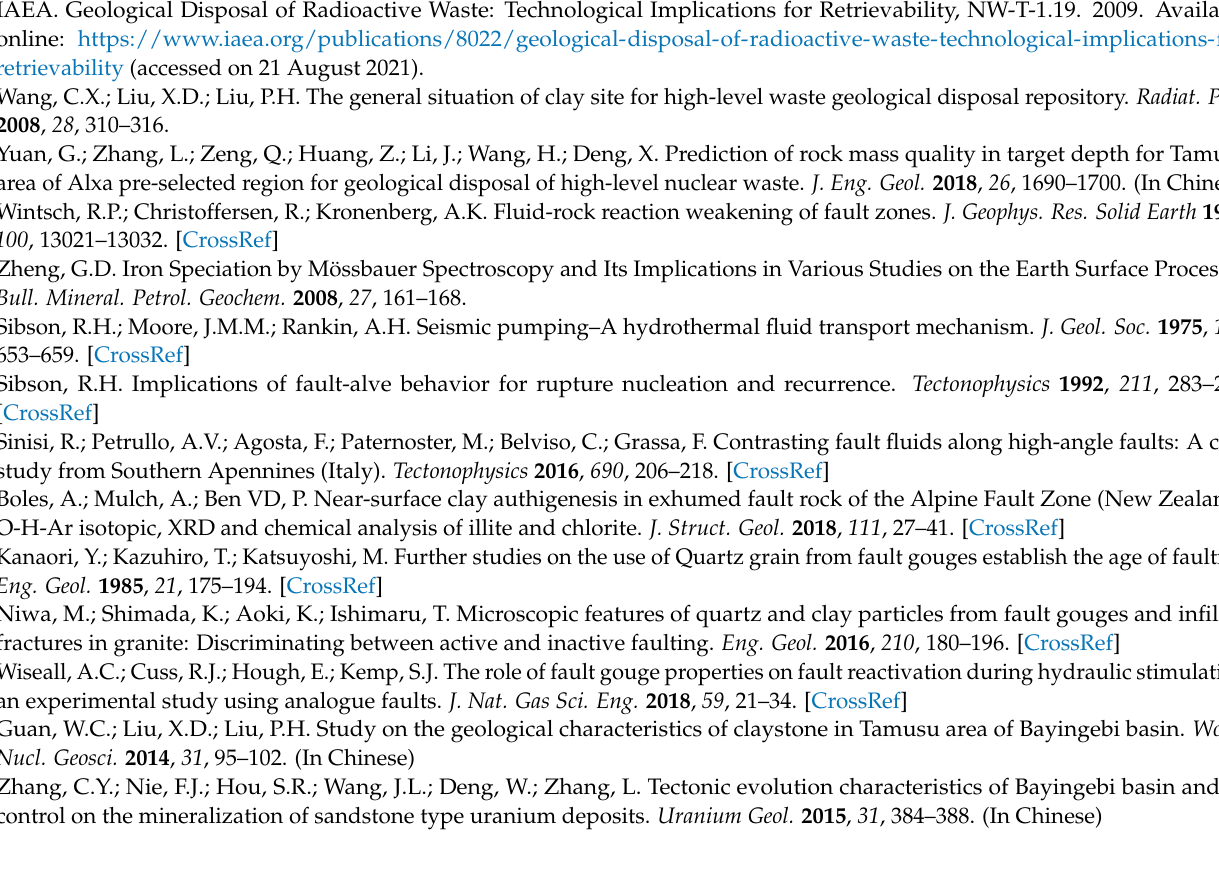
area. Table S1: Sample characteristics and sampling location. Table S2: Major element content in fault gouge and host rock. Table S3: Carbon and oxygen isotope compositions of fault gouge and host rock. Table S4: Mossbauer parameters and relative contents of various iron species in fault samples from Tamusu area. Table S5: Micro morphological classification and relative chronology of quartz in fault gouge. Table S6: Micro morphology type and formation age of quartz grains in fault